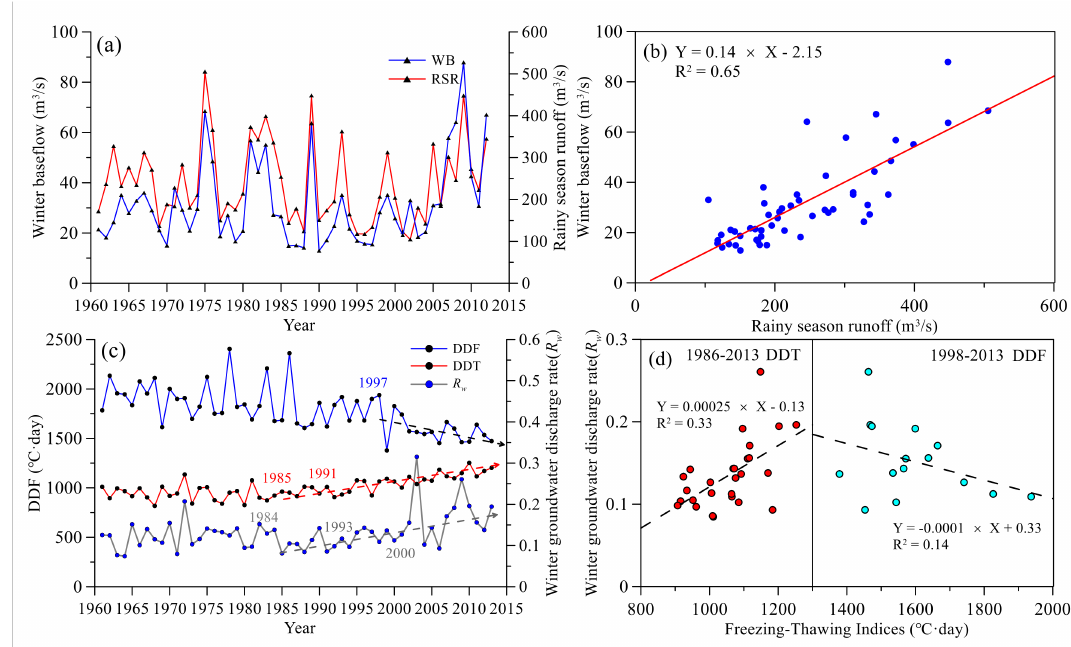
Figure 9. ( a ) Inter-annual variation of rainy season runo ff and winter baseflow ( b ) correlation of winter baseflow and rainy season runo ff ( c ) Inter-annual variation of freezing–thawing indices (DDF, DDT) and winter groundwater discharge rate ( R w ) ( d ) The correlation between freezing–thawing indices (DDF, DDT) and winter groundwater discharge rate ( R w